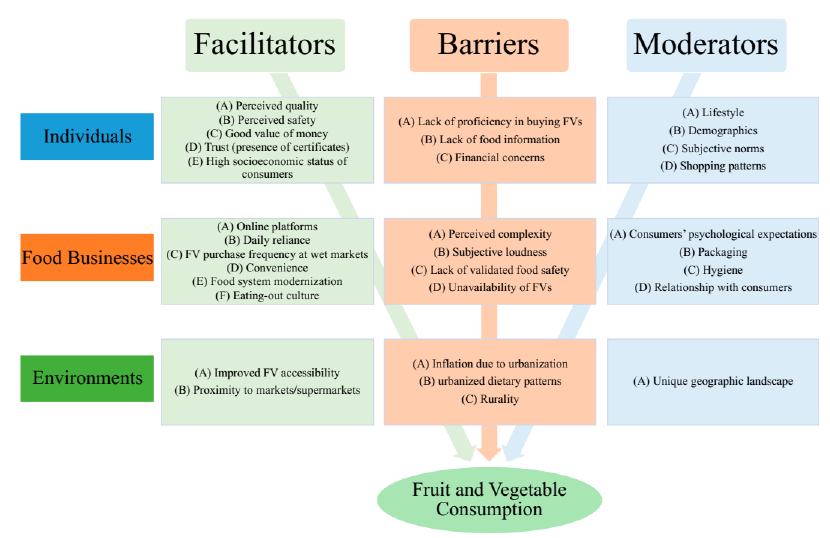
Figure 3. The overview of the facilitators, barriers, and moderators of FV